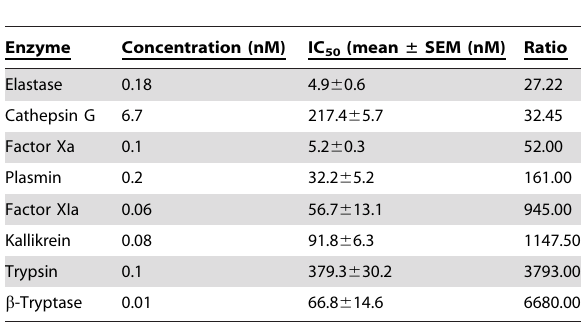
Table 1. IC 50 values for rSimukunin against various serine proteases.